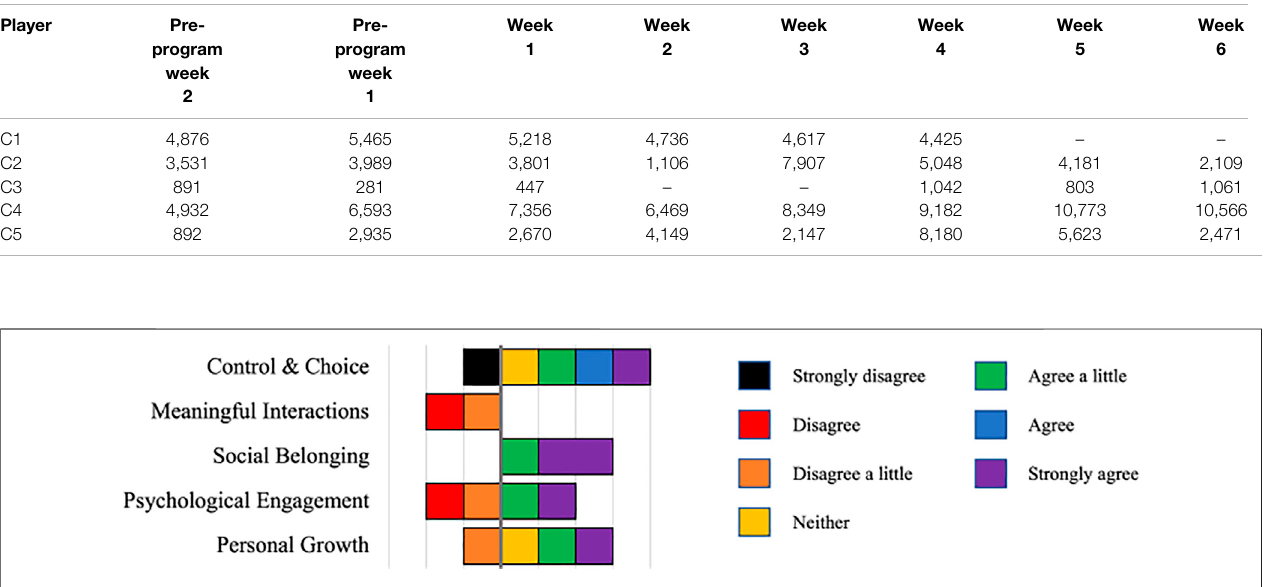
Frontiers in Virtual Reality |